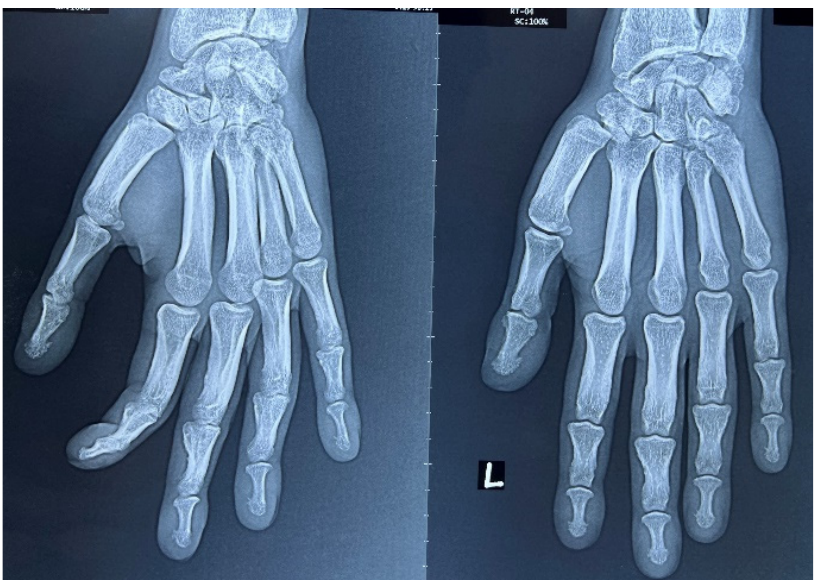
Figure 6. X-rays of the left hand (2022) showing that periosteal hypertrophy and calcifications had disappeared but that the soft tissue around distal phalanges was still swollen.